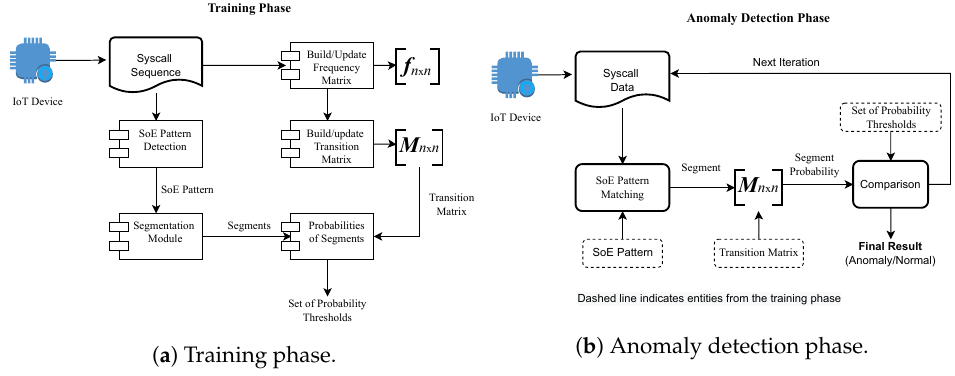
Figure 2. Block diagram of ( a ) training and ( b ) anomaly detection phases of the proposed approach.